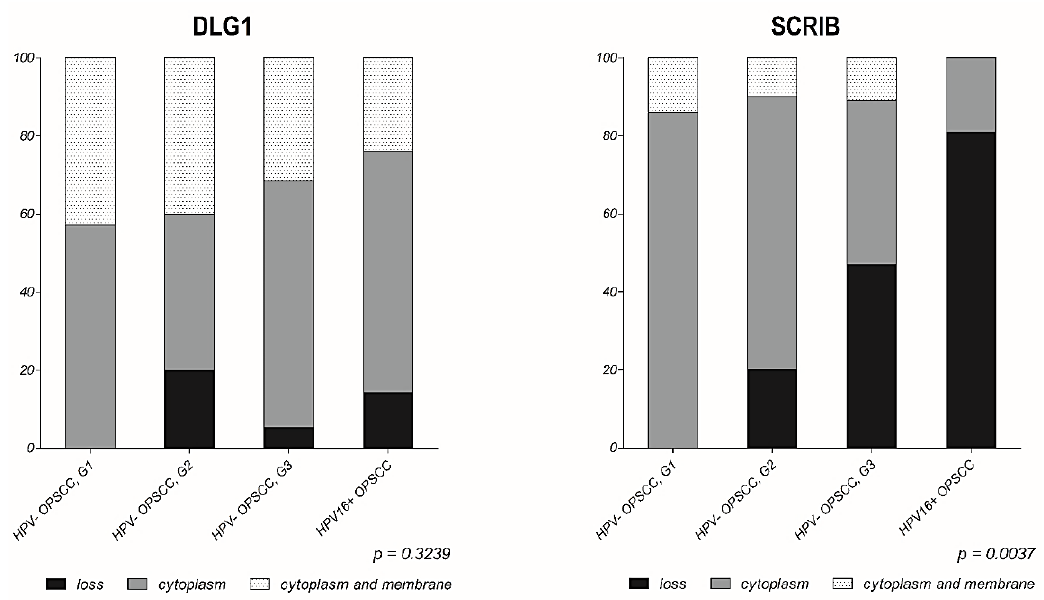
Figure 6. Changes in expression and localization of DLG1 and SCRIB proteins in HPV-positive OPSCCs and HPV-negative OPSCCs of various grades. Black bars show the percentage of FFPE samples with a complete loss of antigen. Light grey bars represent the percentage of samples with only cytoplasmic localization of antigen. Dark grey bars represent the percentage of samples with both cytoplasmic and membranous localization of antigen. p -values are 0.3239 and 0.0037 for DLG1 and SCRIB, respectively.